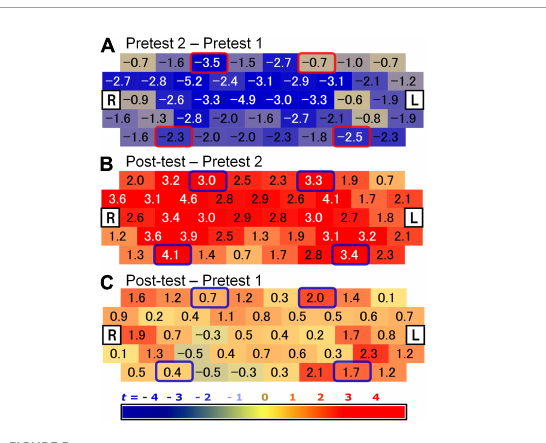
p < 0.05] areas. However, no significant difference in cerebral blood flow was found in left DLPFC area [ t ( 15 ) = − 0.69, p ≥